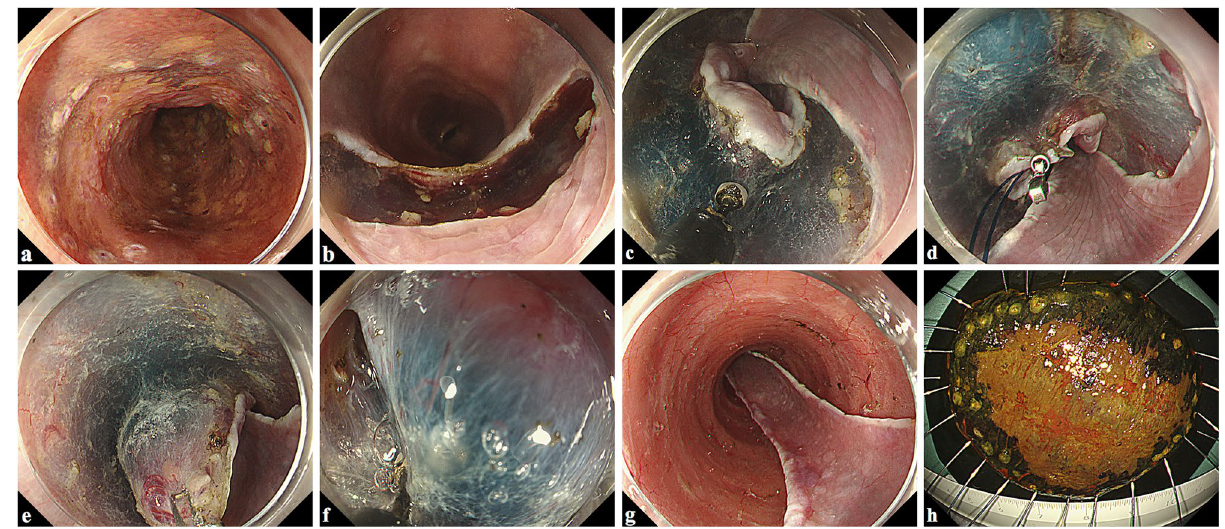
Figure 1. Steps of traction-assisted endoscopic submucosal dissection for large esophageal cancer. ( a ) Marking dots were made after lugol chromoendoscopy. ( b ) The anal incision was performed. ( c ) The circumferential incisions and trimming the submucosa at the edge of the incision were completed. ( d ) The traction clip was anchored to anchored to the oral edge of the specimen. ( e ) During submucosal dissection, the traction thread was pulled in the oral direction with a sinker. ( f ) The clip-with-line traction method provides good visualization and tension of the submucosa. ( g ) After resection of the tumor. ( h ) Resected specimen after iodine staining. Complete en bloc resection is